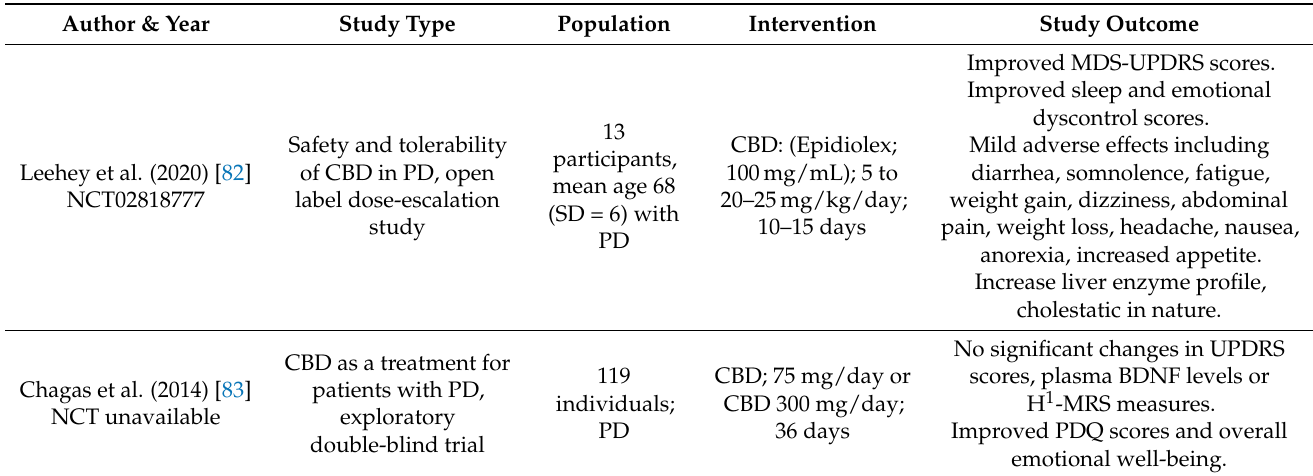
Table 8. Summary of the characteristics of clinical human trials investigating the use of CBD in patients with PD. Author &